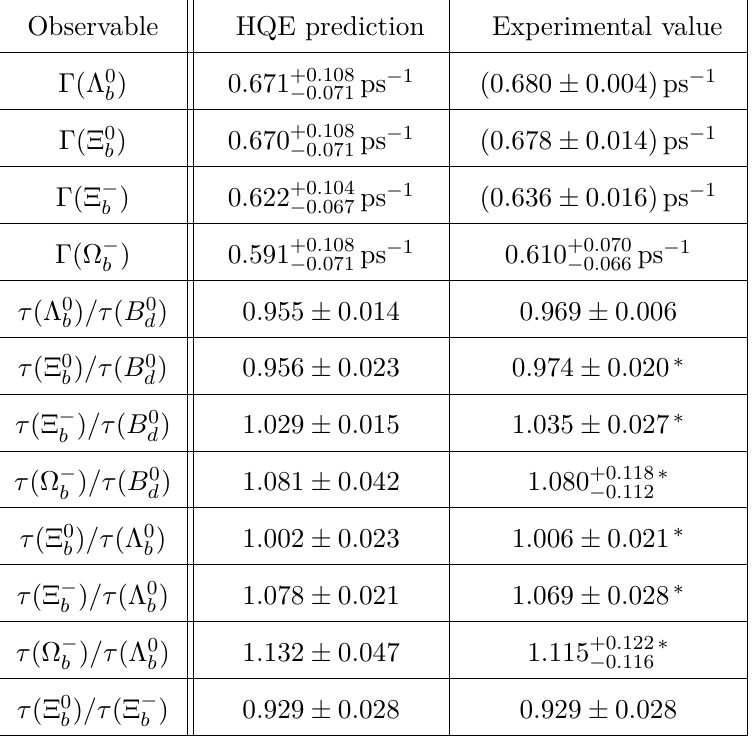
Table 6 . Comparison between our predictions based on the HQE and the data. The theoretical uncertainties are obtained by combining uncertainties due to input parameters, the renormalisation scales µ 0 , µ 1 , and µ h , and missing 1 /m 4 corrections. The experimental numbers marked with an b asterisk are obtained by dividing the corresponding values shown in table 1, and do not take into account possible experimental